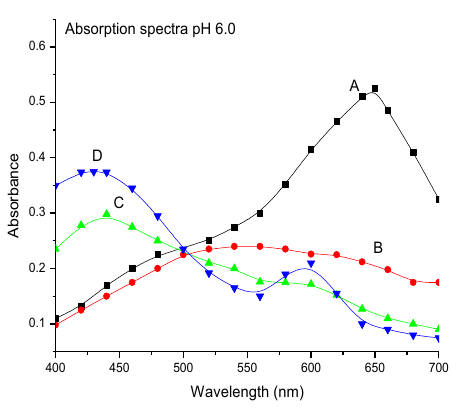
Figure 5. Absorption spectra of Tb at pH 6.0, A- ECAB-CDMEAB-Tb-(Ternary complex). B- ECAB-Tb at(pH 6.0)-(Binary complex), C - ECAB-CDMEAB-(Modified reagent), D - ECAB-(Reagent).